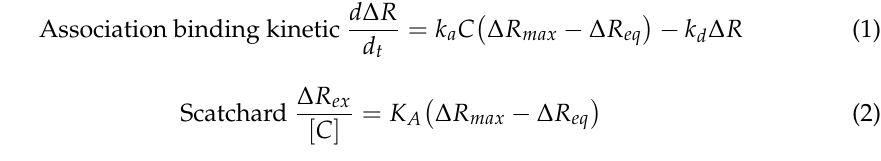
Table 2. Kinetic and isotherm parameters of MIP − based plasmonic